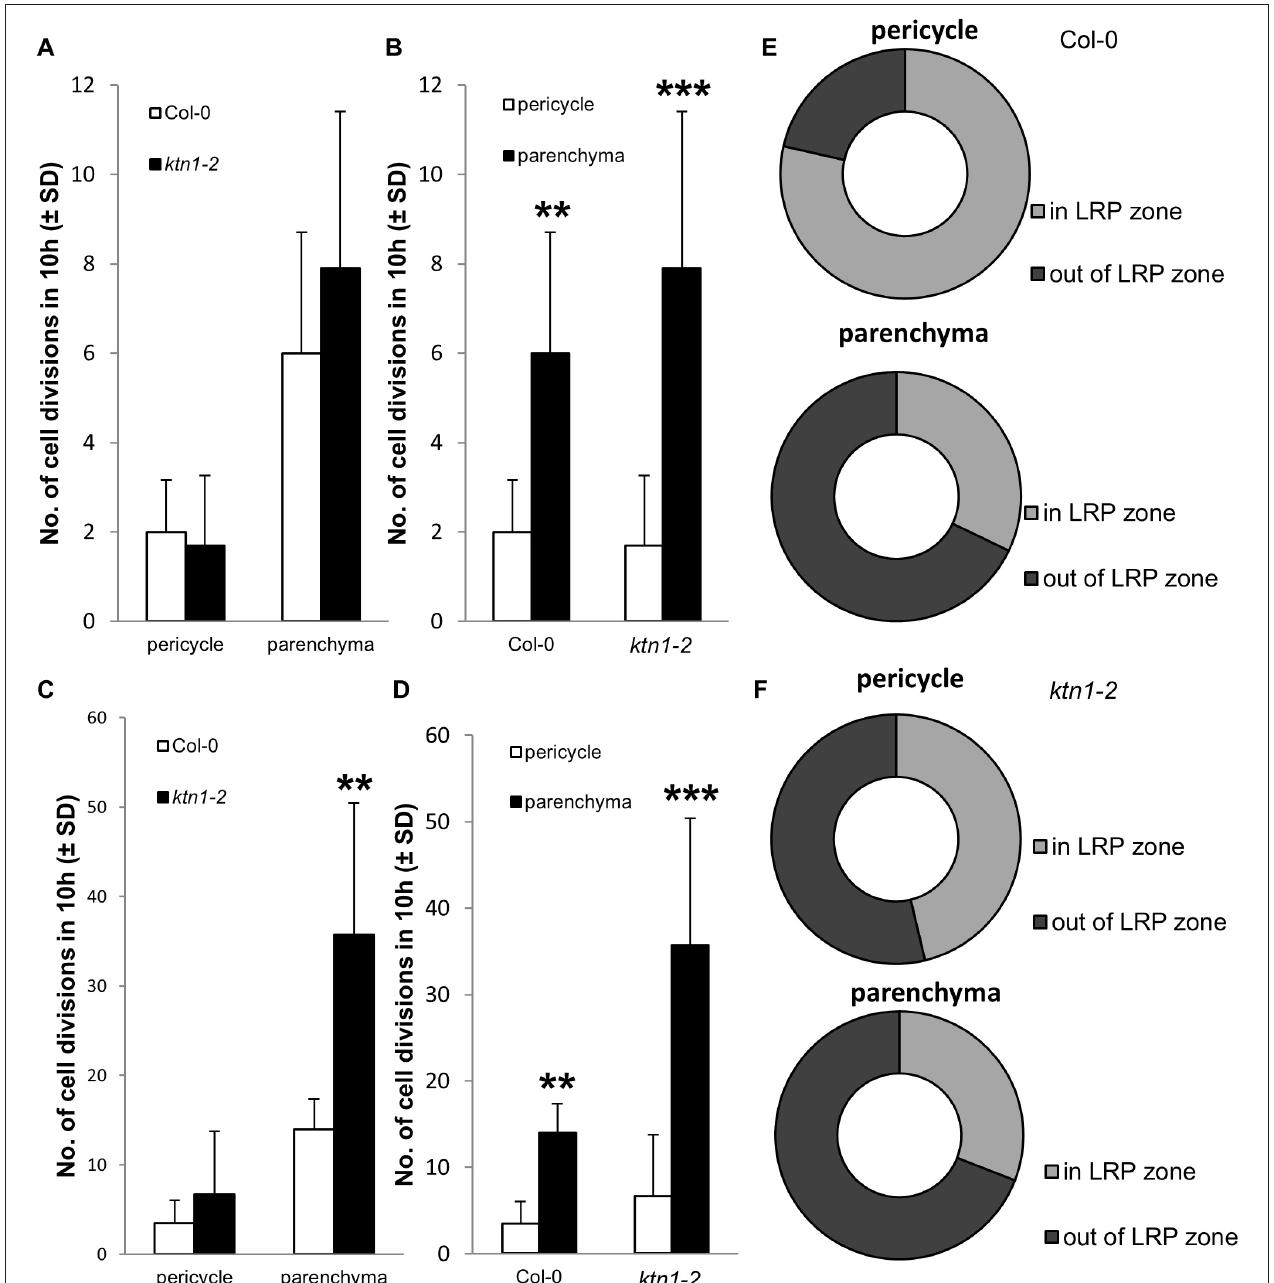
FIGURE 9 | Proliferative transversal and longitudinal cell divisions in central cylinder of primary roots in Col-0 and ktn1-2 mutant. (A,B) Number of proliferative transversal cell divisions in pericycle and stelar parenchyma, which is increasing the number of cells in individual cell files, in Col-0 and ktn1-2 mutant. (C,D) Number of longitudinal cell divisions in pericycle and stelar parenchyma, which is increasing the number of cells or cell files in radial pattern of the central cylinder, in Col-0 and ktn1-2 mutant. (E,F) Ratio of longitudinal cell divisions occuring in the central cylinder at the place of LRP formation (LRP zone) and outside of the place of the LRP formation (out of LRP zone), quantified separately for pericycle and stelar parenchyma in Col-0 (E) and ktn1-2 mutant (F) . Cell divisions were counted in pericycle and stelar parenchyma cells in mature part of the primary root at the place of first lateral root primordium establishment within the field of view of 438.5 × 438.5 µ m and time period of 10h in roots of 5 days old seedlings. Calculations are based on data collection from 102 dividing cells of 4 Col-0 seedlings and 520 dividing cells of 7 ktn1-2 seedlings. Asterisks indicate statistical significance between measurements (** p < 0.01, and *** p < 0.001).